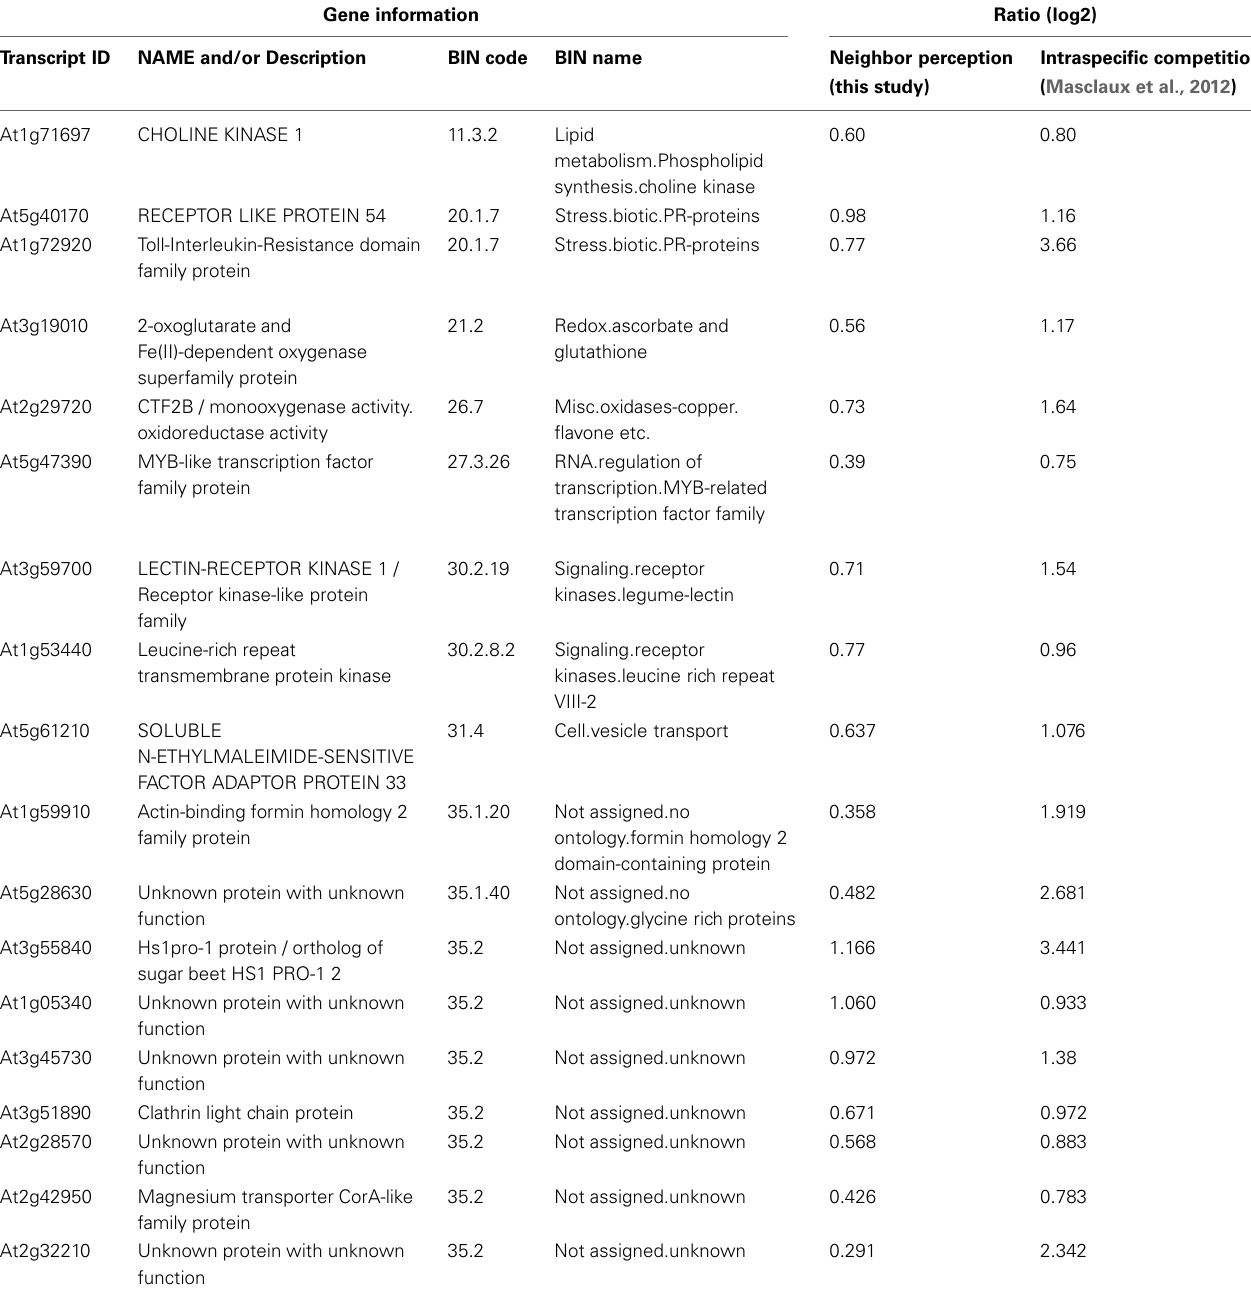
Table 3 | List of induced transcripts regulated in concordance with transcriptional responses to intraspecific competition as examined by Masclaux et al.